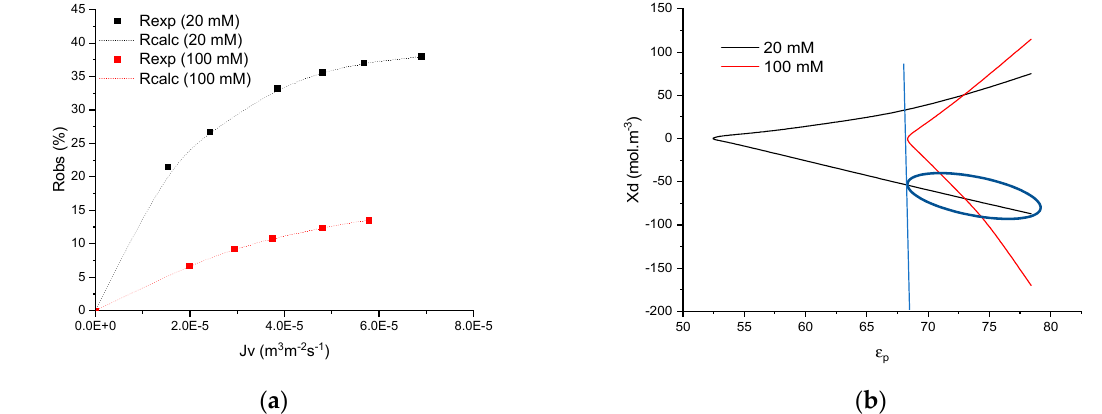
Figure 1. ( a ) Rejection curves of NaF obtained with TiO 2 membrane for two feed concentrations (20 and 100 mol m − 3 ). Symbols: experimental values and lines: simulated curves obtained with the various best-fitted parameters ( X d and ε p ) plotted in ( b ).